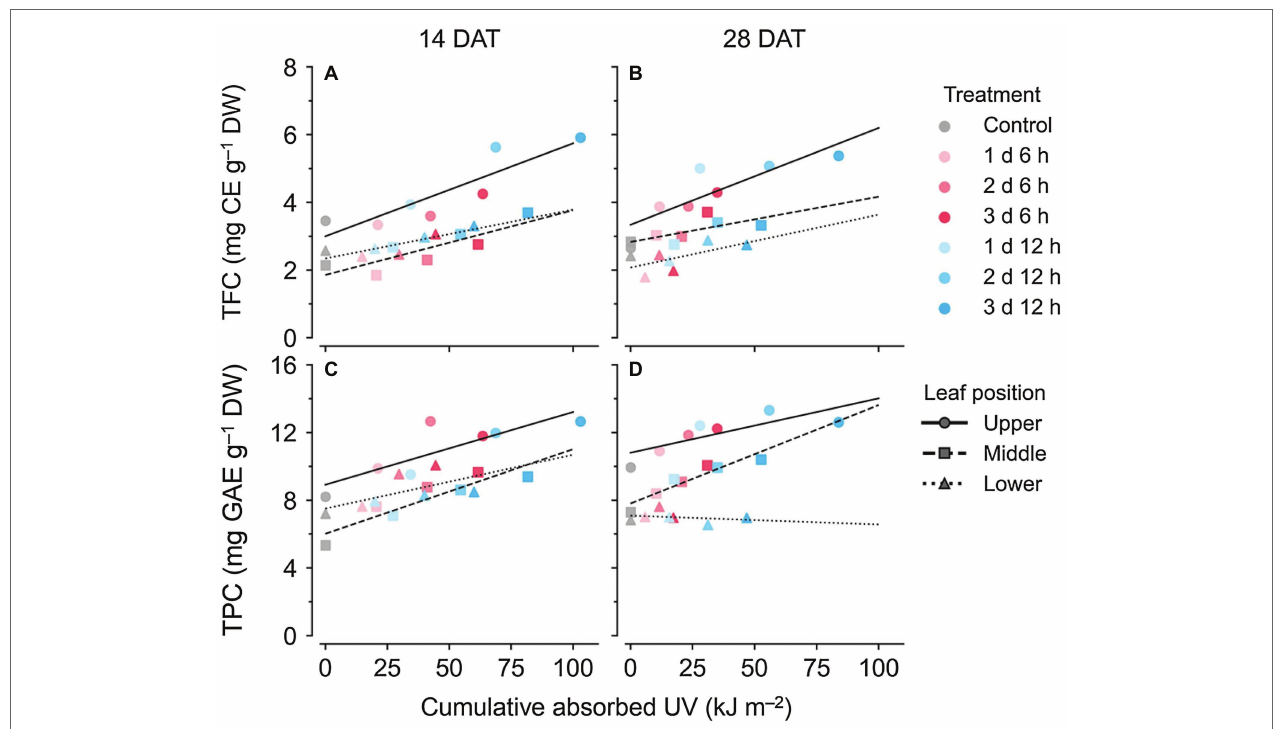
FIGURE 6 | Relationships between compound concentrations and cumulative absorbed UV for 3 days of kales grown under the control and UV-B treatments according to leaf position and growth stage; total flavonoid compounds (TFC; A,B ) and total phenolic compounds (TPC; C,D ) at 14 (A,C) and 28 (B,D) days after transplanting (DATs). The cumulative absorbed UV means the integration of UV irradiation absorbed by each leaf for 3 days. Refer to Figure 1C for the UV-B treatments and Table 1 for R 2 of the linear regression. TABLE 1 | Coefficients of determination ( R 2 ) from linear regressions for bioactive compound contents and from nonlinear regressions for change rates